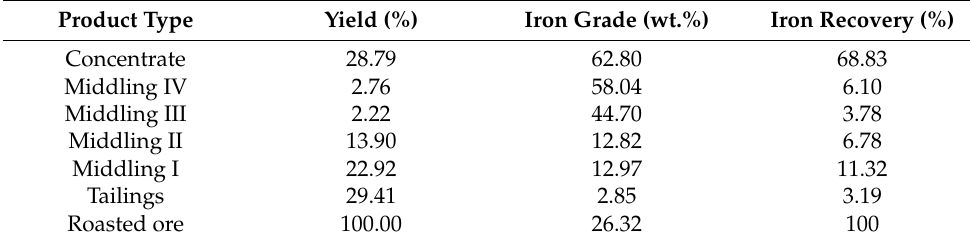
Table 6. Analysis results of the iron grade, recovery, and